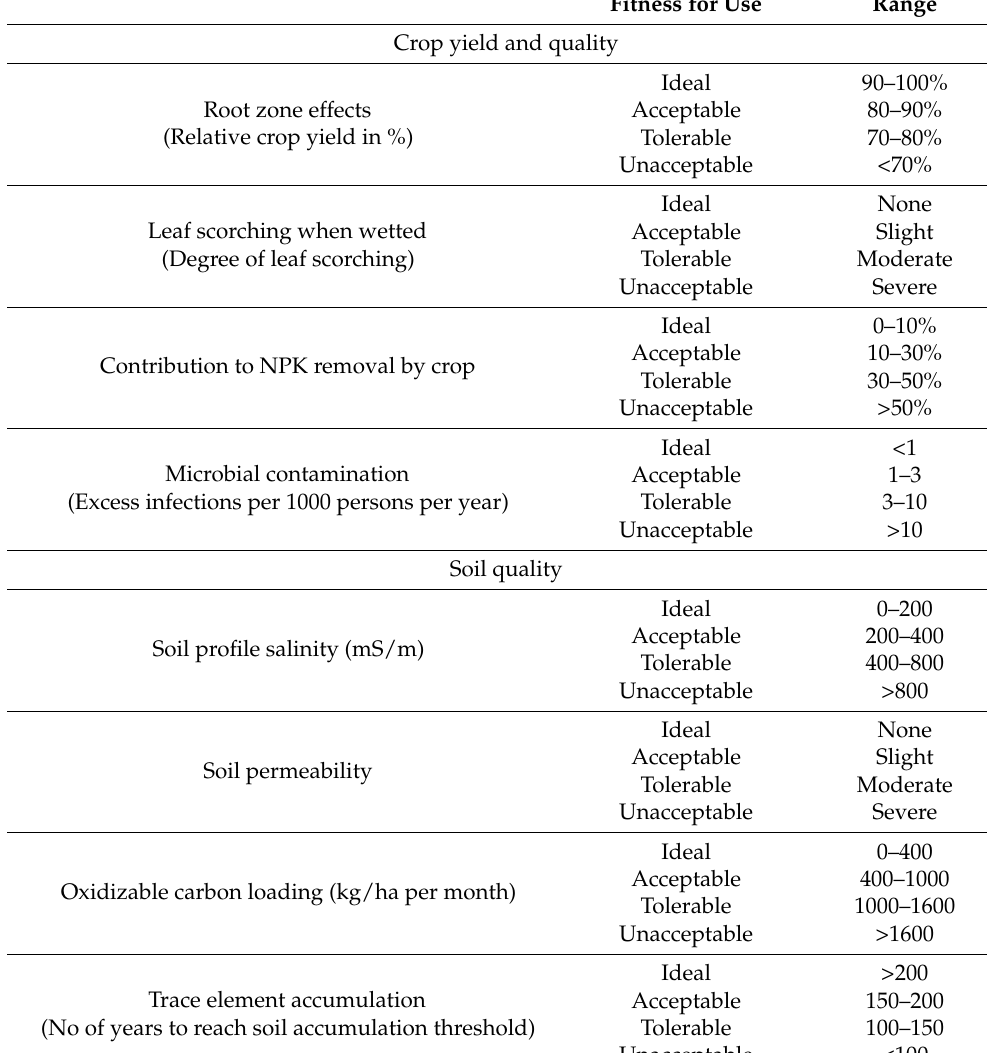
Table 3. Crop yield and quality, soil quality, impacts on irrigation equipment and with a specific amount of irrigation (predicted by the DSS)